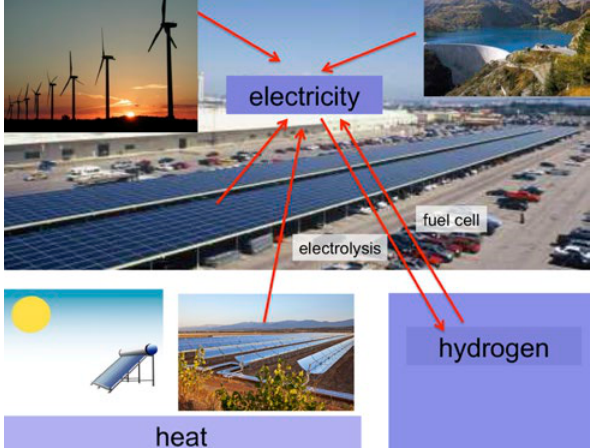
Figure 3. Conversion of primary energy (fossil fuels or wind/solar energy) into electricity and mechanical energy (adapted from 10